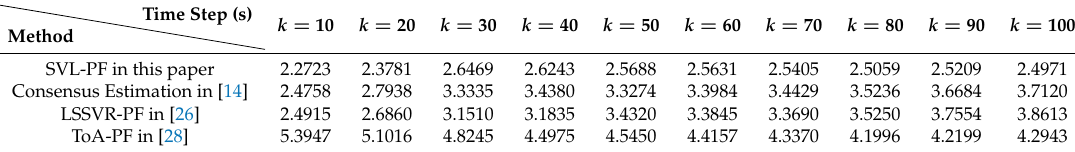
Table 2. The average localization errors in the universal noise condition.